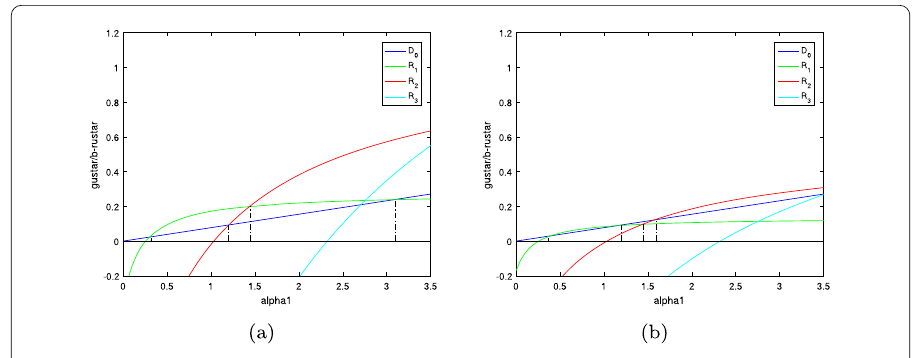
Figure 1 Bifurcation diagram in the double parameters plane at the positive steady state E 4 , where b = 0.35, δ = 0.6, m 1 = 0.5, m 2 = 0.3, h = 0.3, l = 1, d 1 = 0.02. ( a ): d 2 = 0.35. ( b ): d 2 =